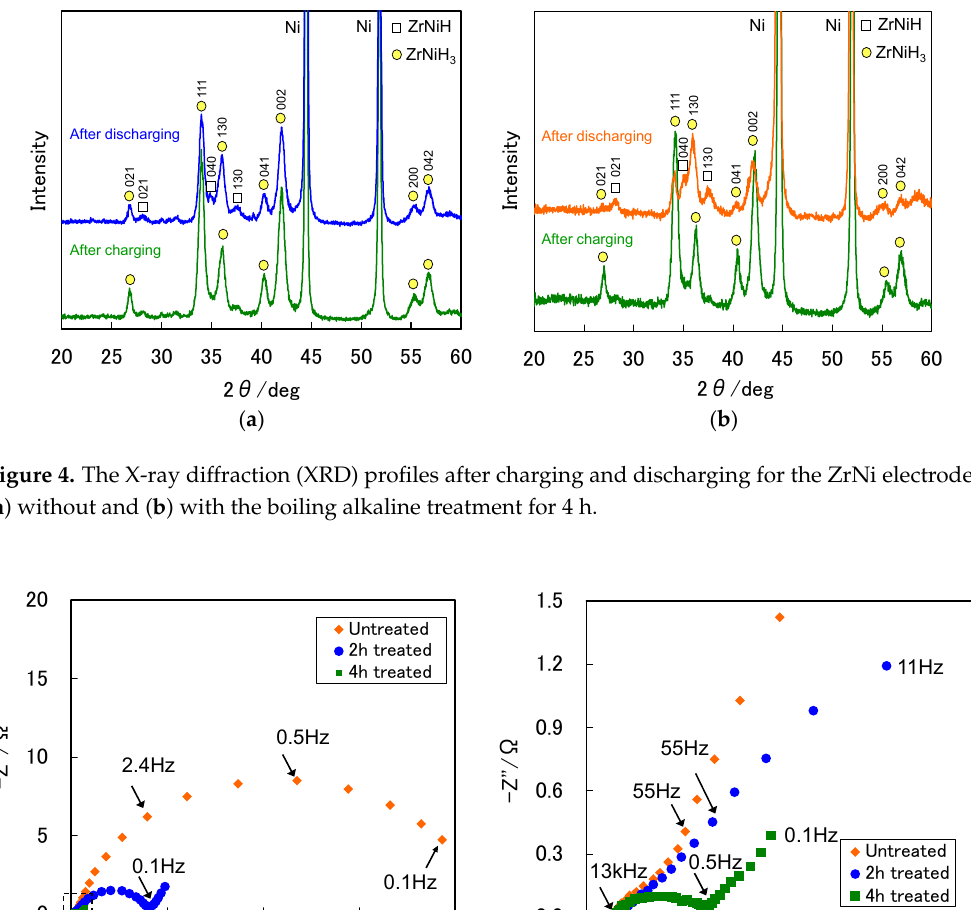
Figure 5. ( a ) Nyquist plots; ( b ) enlarged Nyquist plots for the fully charged ZrNi alloys with and without the boiling alkaline treatment for 2 h and 4 h; and ( c ) equivalent circuit.